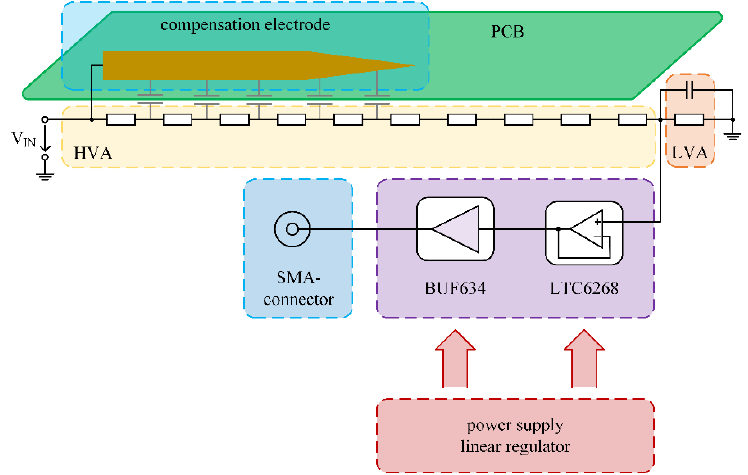
Figure 7. Block diagram of the resistive voltage divider with the pentagon compensation electrode geometry, buffer amplifier consisting of the LCT6282 and the BUF634, along with a corresponding power supply.